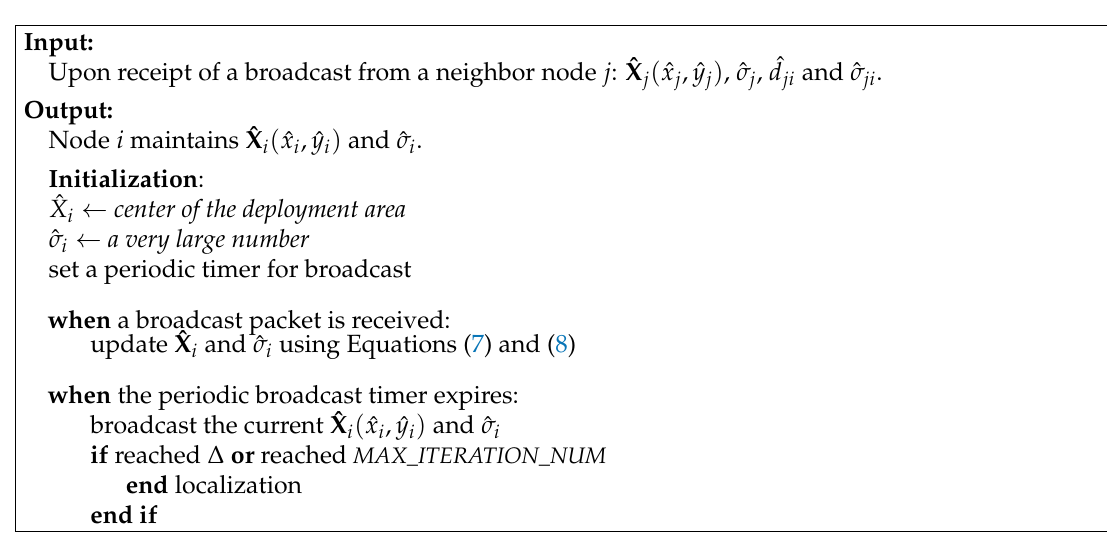
Figure 3. KickLoc Intuitive algorithm that runs on unknown node i